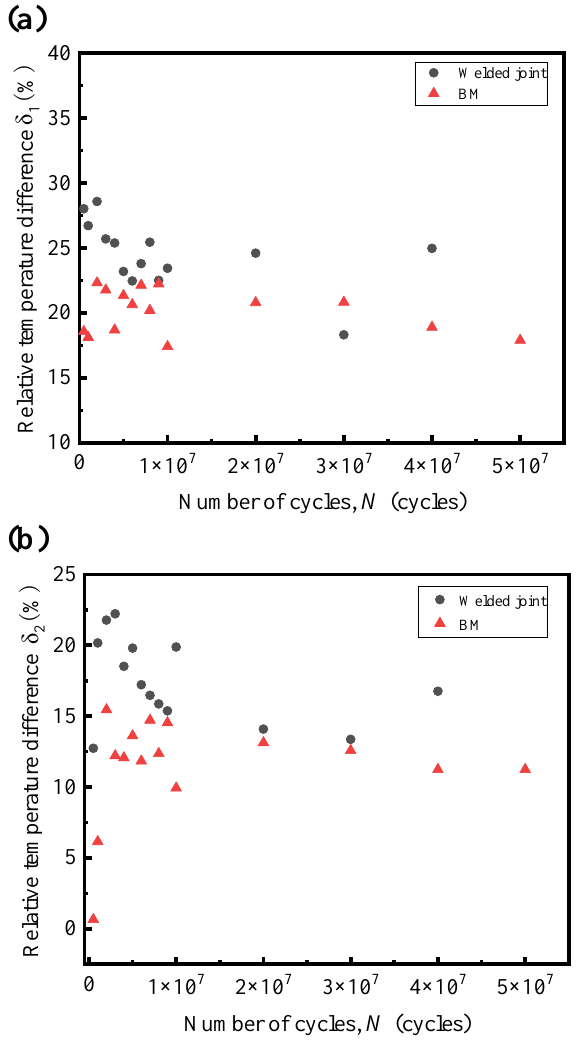
Figure 9. Relative temperature difference versus the number of cycles: ( a ) δ 1 , ( b ) δ 2 .